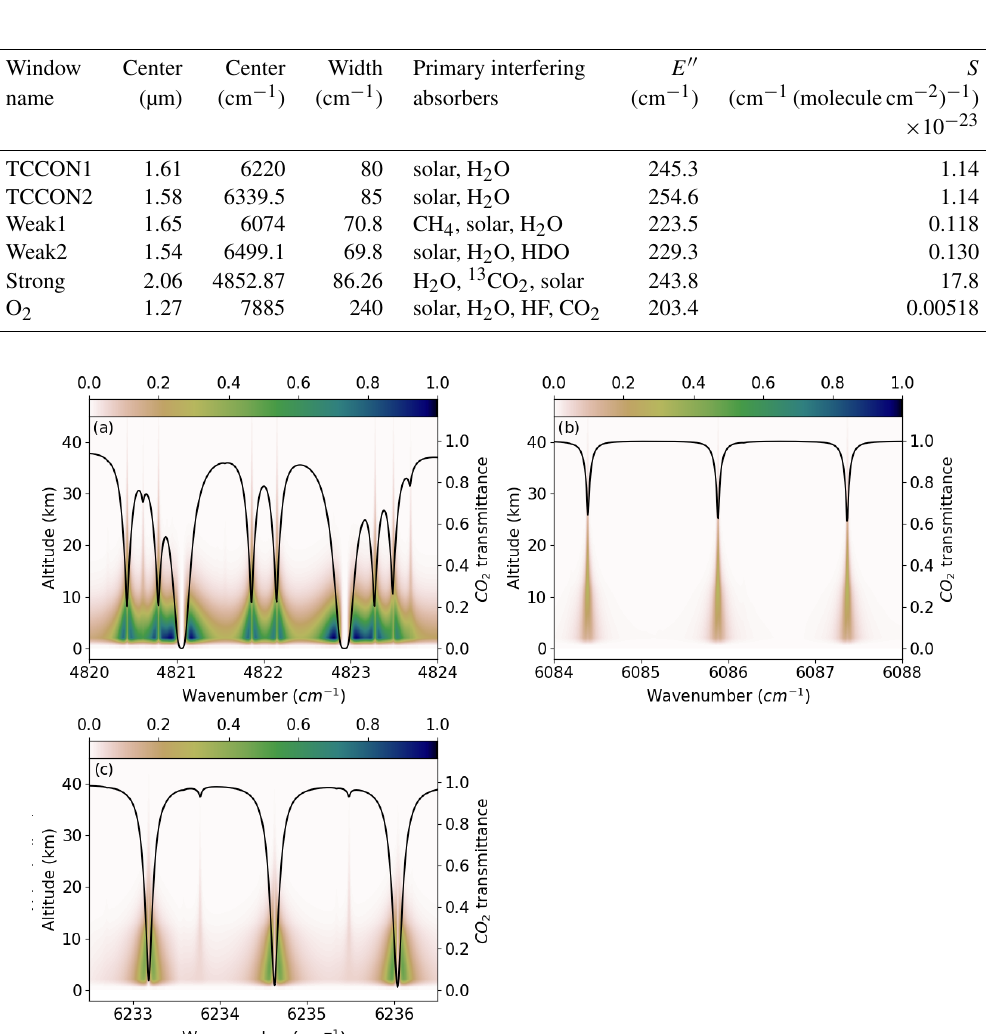
Figure 2. CO 2 absorption lines (black line) overlaid on heat maps of the CO 2 Jacobian for lines of (a) the Strong window, (b) the Weak1 window, and (c) the TCCON1 window. The color bar represents the normalized Jacobian where 1 corresponds to the maximum amongst all the CO 2 Jacobians from the five CO 2 windows. Lines of the Weak2 and TCCON2 windows are not shown as they look like the Weak1 and TCCON1 windows,